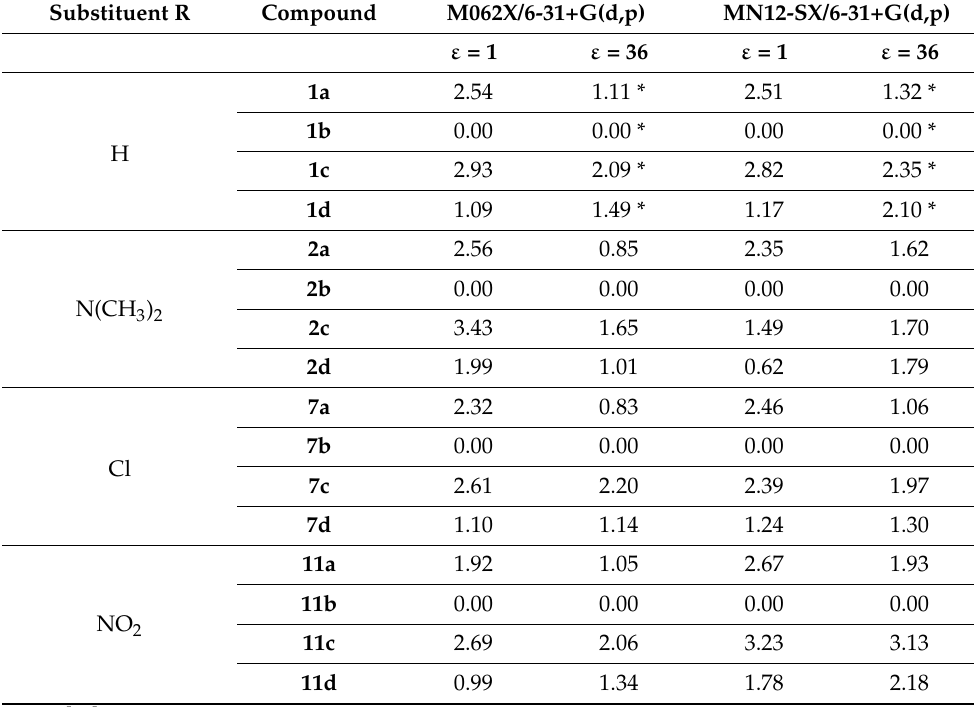
Figure 3. Selected E -isomers ( 1a and 1b ) and Z -isomers ( 1c and 1d ) of compound 1 .